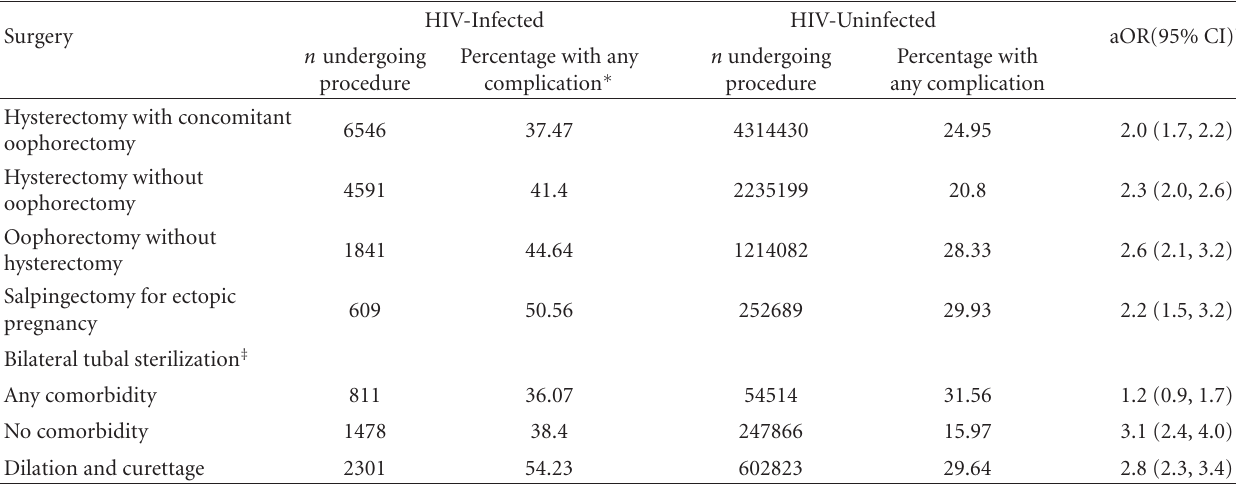
Table 2: Estimated numbers of specific procedures, percentages with any complication, and adjusted odds ratios for experiencing at least one complication, by HIV status, for selected gynecological surgeries (United States,